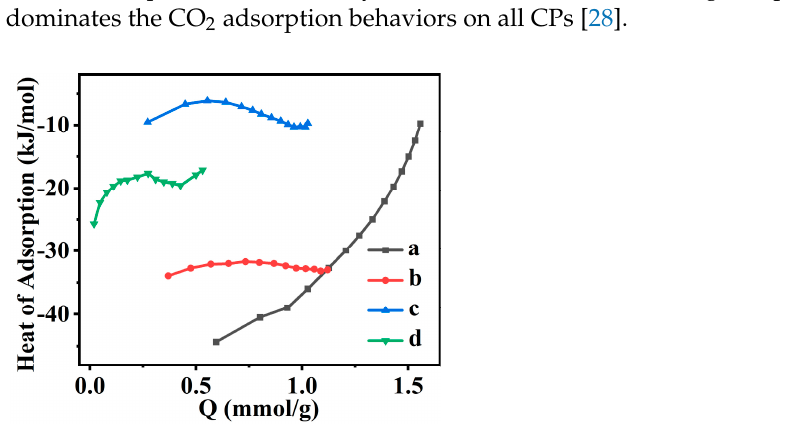
Figure 10. The isosteric heat of CO 2 adsorption for CP (a), Fe(0.03) − H(0.05) − CP − 3 (b), Fe(0.03) − H(0.05) − CP − 9 (c), and Fe(0.03) − H(0.00) − CP − 9 (d).